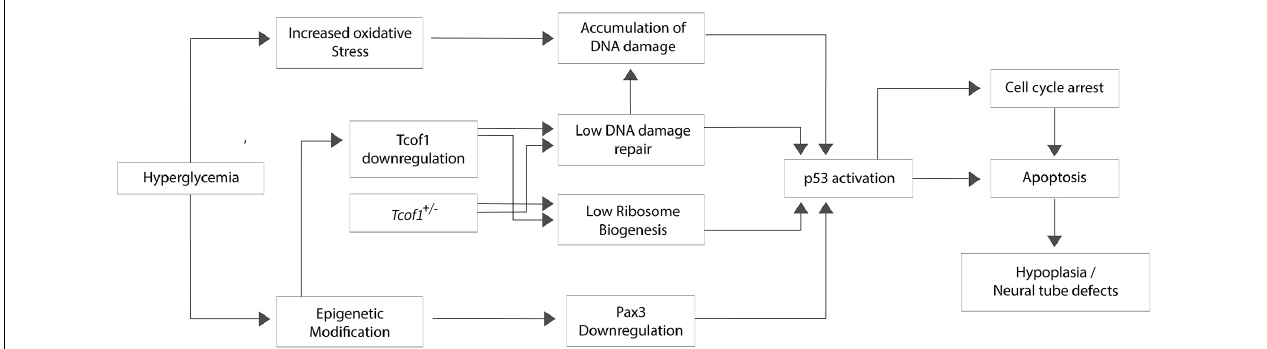
FIGURE 2 | Potential mechanisms for hyperglycemia, oxidative stress, and DNA damage in the pathogenesis of Treacher Collins syndrome. The hyperglycemic environment characteristic of maternal diabetes can lead to oxidative stress and epigenetic modification. Oxidative DNA damage and aberrant Pax3 silencing lead to p53 activation which induces apoptosis particularly within neuroepithelial cells and neural crest cells, resulting in neural tube defects or hypoplasia of neural crest-derived tissues.